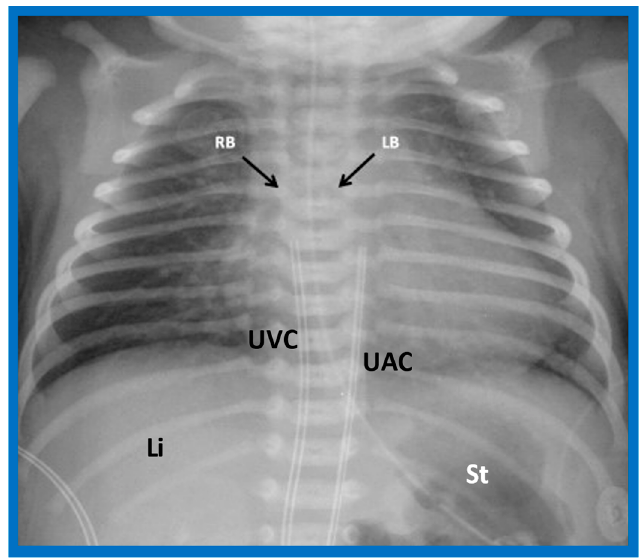
Figure 23. A chest roentgenogram of a patient with situs solitus demonstrating a wide and short right bronchus (RB) which descends somewhat steeply, whereas the left-sided bronchus (LB) is narrow and long and traverses horizontally. The liver (Li) is seen on the right side, and the stomach (St) bubble is seen on the left side, consistent with situs solitus. Mild cardiac enlargement and increased lung vascular patterns are also seen. UAC indicates an umbilical arterial catheter, and UVC points to the catheter in the umbilical vein. Modified from reference [4].